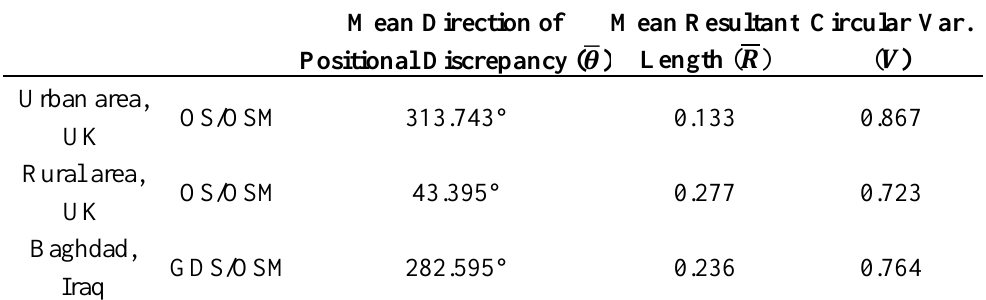
Table 3. Circular statistics for comparisons of geospatial datasets.